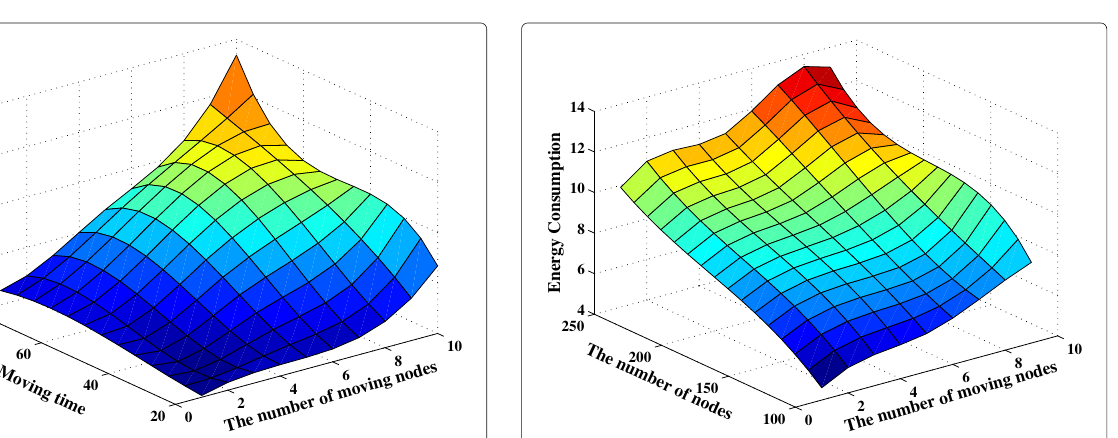
Fig. 5 The relation between energy consumption and moving time, the number of moving nodes